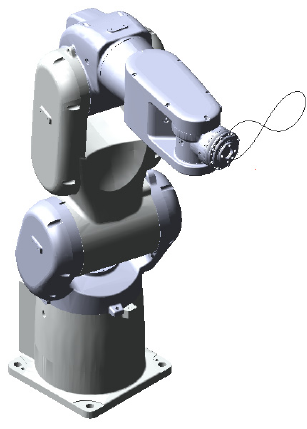
Figure 14. Simulation result.